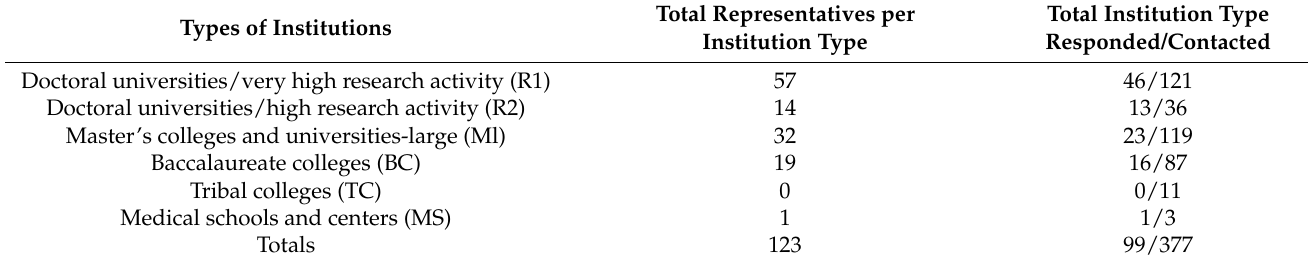
Table 1. Number of survey respondents from different types of institutions, and total number of institutions with any survey respondents. There were 13 institutions that submitted multiple survey responses from different personnel. The number of duplicate responses ranged from 2–8, with 2 being the median number of duplicates (R1: n = 19, R2: n = 2, ML: n = 11, BC: n = 5; where n = number of duplicates).